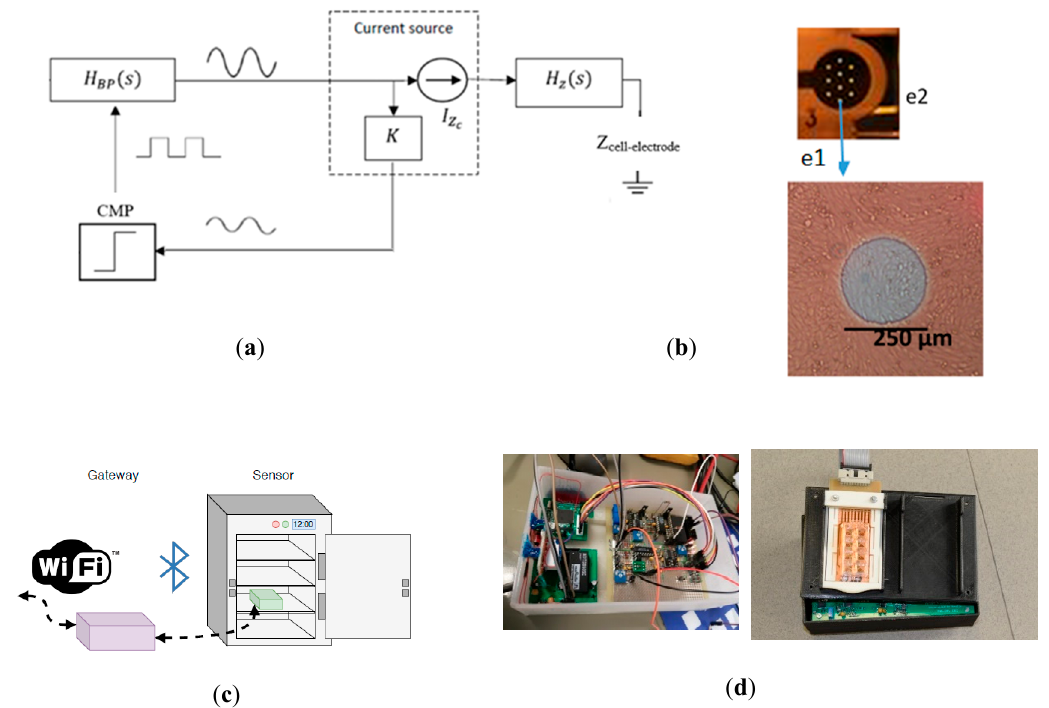
Figure 1. Oscillation-based circuit. ( a ) Block diagram of the circuit proposed, composed by the bioimpedance block (H z (s)), comparator, and bandpass filter (H BP (s)). The complete circuit prototype